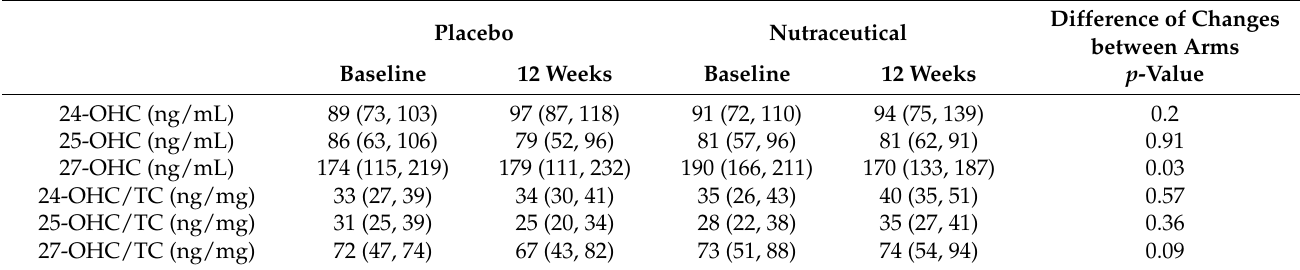
Table 3. Determination of serum levels of 24-hydroxycholesterol (24-OHC), 25-hydroxycholesterol (25-OHC) and 27- hydroxycholesterol (27-OHC) and their ratio to total cholesterol